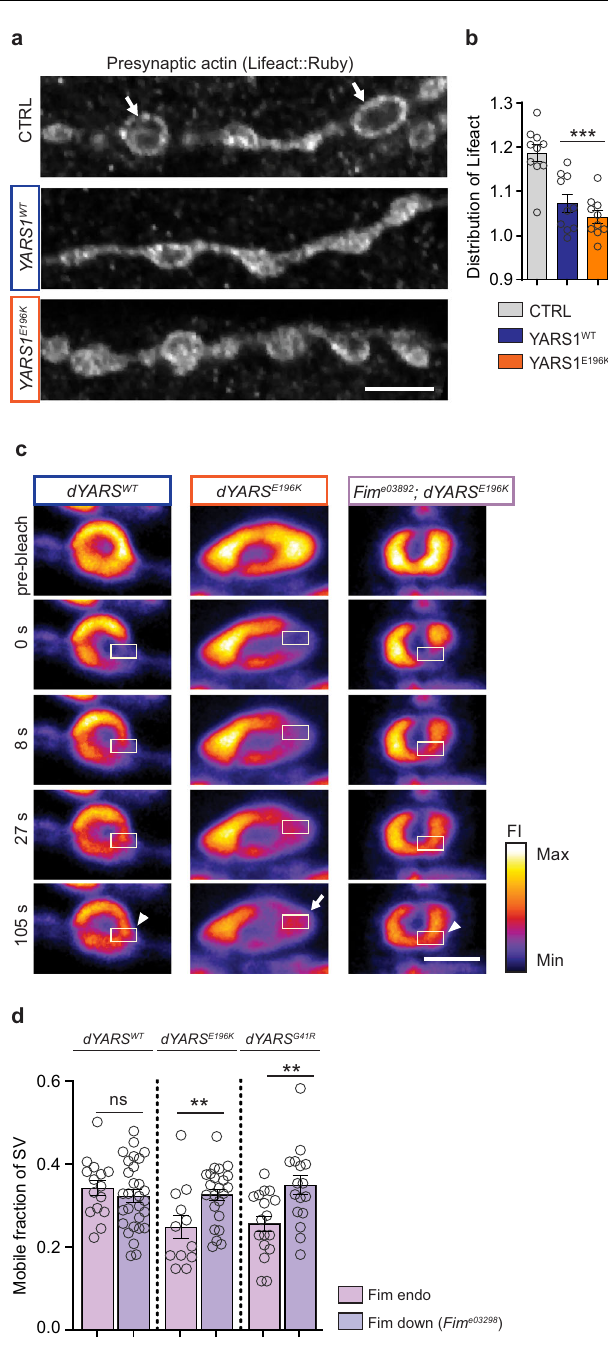
Fig. 5 | Characterization of YARS1 CMT -induced defects at the Drosophila larval NMJ by genetic modulation of the actin-bundling protein Fim. a Neuronal expression of YARS1 rearranges presynaptic F-actin (Lifeact::Ruby) from the bou- ton border proximity (arrows) inwards. Scale bar – 5 µ m. b Quanti fi cation of the Lifeact::Ruby signal redistribution, as detailed in the Methods and Supplementary Fig. 8a; n =12 NMJs from six larvae per genotype; *** p =0.0006 and p <0.0001 for YARS1 WT andYARS1 E196K respectivelyafteratwo-sidedunpaired t test. c FRAPimage sequences of the SV marker Syt::eGFP co-expressed with dYARS1 WT or dYARS1 CMT . Scalebar – 2 µ m. d Themobilefractionofsynapticvesicles,determinedbyFRAPof theSyt::eGFPsignal,declinesindYARS1 CMT comparedtoYARS1 WT -expressinglarval NMJs,and isrestoredinmutants with decreased Fimlevels( Fim e03892 ); n =15, 29, 12, 23, 17 and 17 individual boutons (from left to right). Data in bar graphs are mean values±SEM.. ** p =0.0064 and p =0.0046 for dYARS1 E196K and dYARS1 G41R , respectivelyafteratwo-sided unpaired t test.Sourcedataare provided asaSource data fi